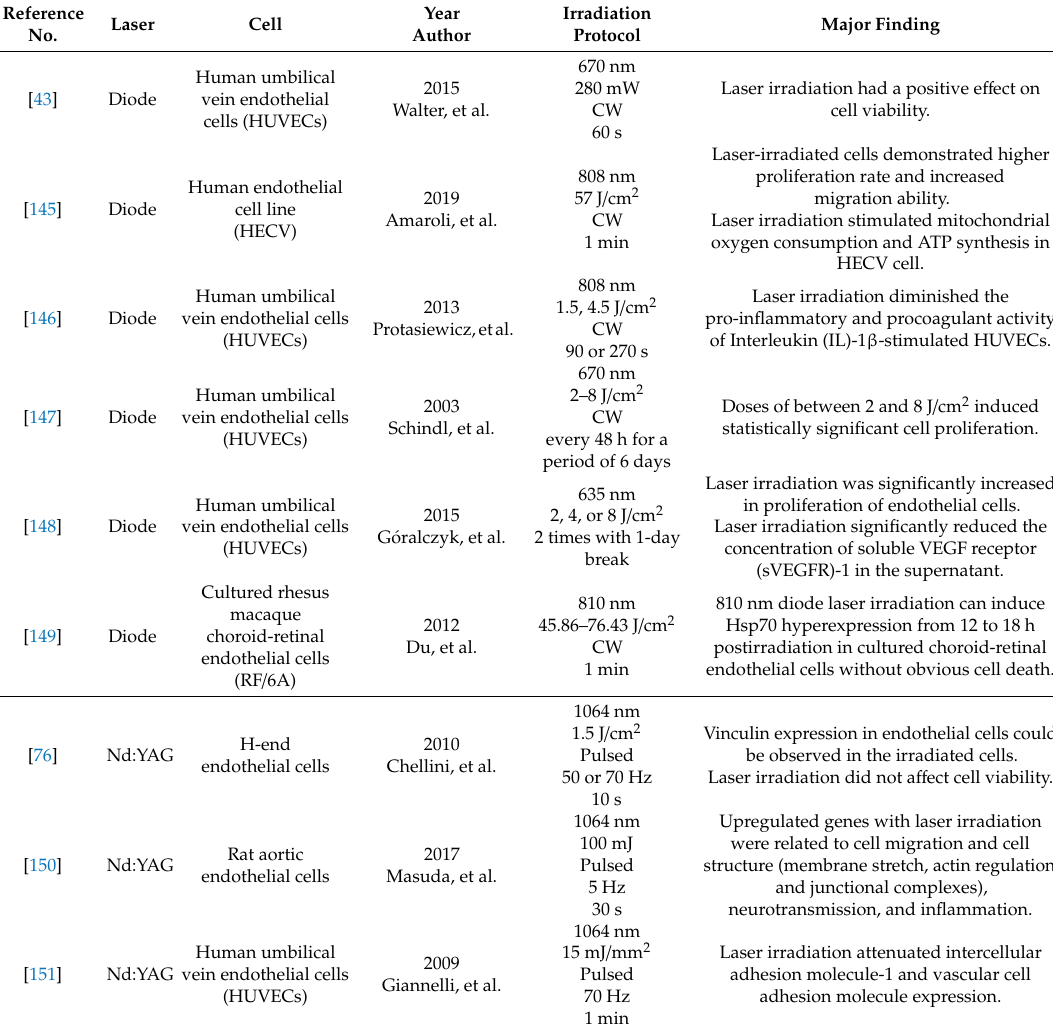
Table 4. Summary of the e ff ects of laser irradiation on endothelial